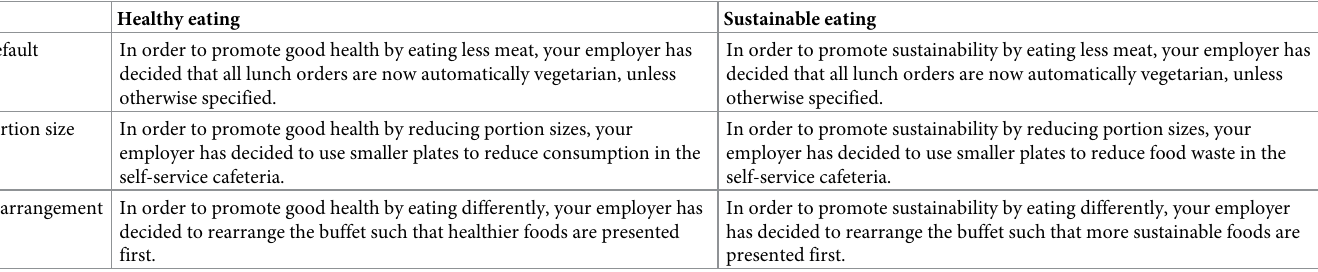
Table 1. The nudge vignettes used in the healthy eating or sustainable eating conditions describing the default nudge, portion size nudge, or rearrangement nudge. Healthy eating Sustainable eating